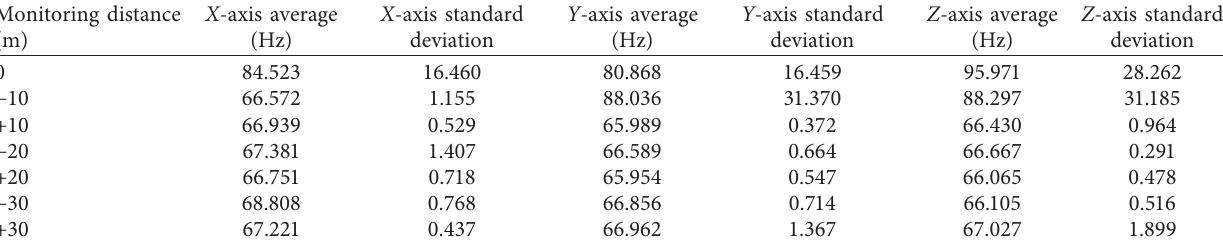
Table 3: Averages and standard deviations of dominant frequency.